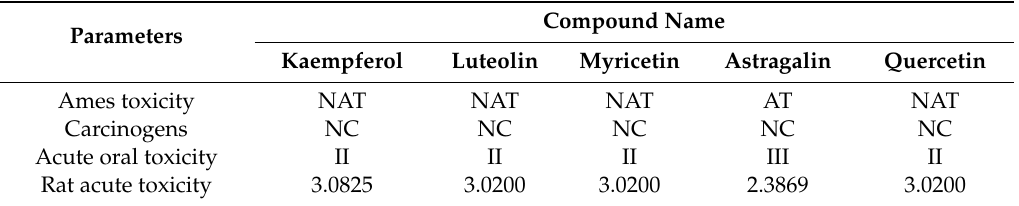
Table 6. Toxicological properties of the major five compounds identified in the molecular docking